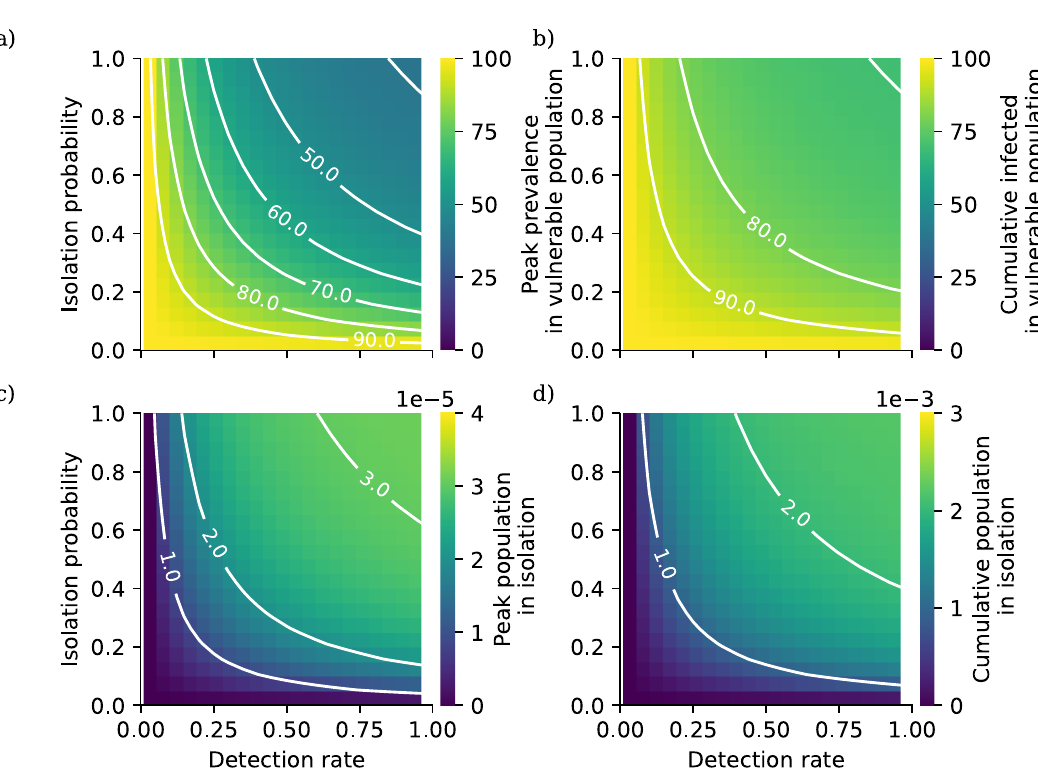
Fig 7. Peak and b) cumulative prevalence among the clinically vulnerable population as a percentage of the baseline values when (OOHI) is not implemented, and c) peak and d) cumulative proportion of less clinically vulnerable adults who enter isolation during the simulation period as a function of detection rate of infectious cases and probability that a detected individual enters